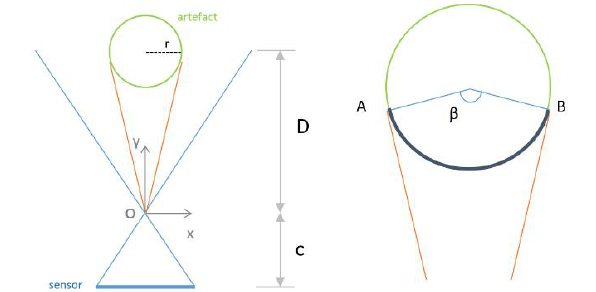
Figure 2. Model to calculate the rotation of the artefact during the acquisition